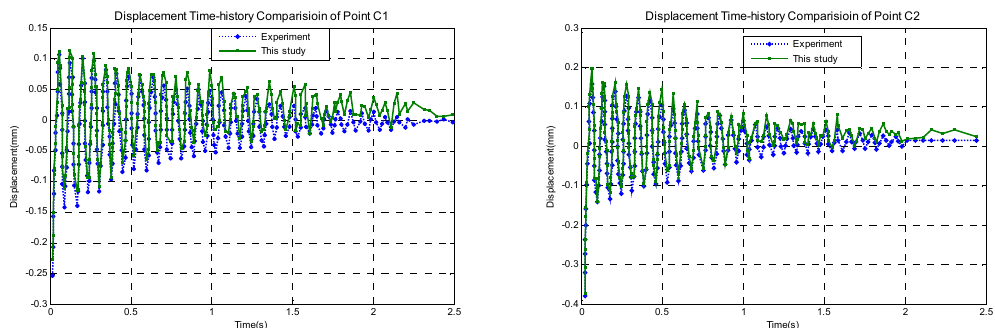
Figure 6. The comparison of the displacement time history of C1 and C2.